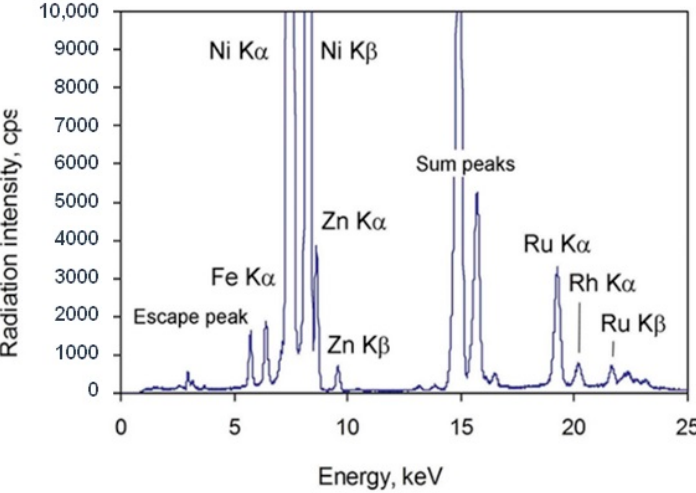
Figure 1. The EDXRF spectrum of 1.0% Ru / Ni on nanowires that were collected using Rh target X-ray tube operating at 30 kV and 300 μ A. Table 1. Results of the EDXRF analysis of the SiO 2 and Ni supported catalysts. Chemical Element [wt.%] Catalyst